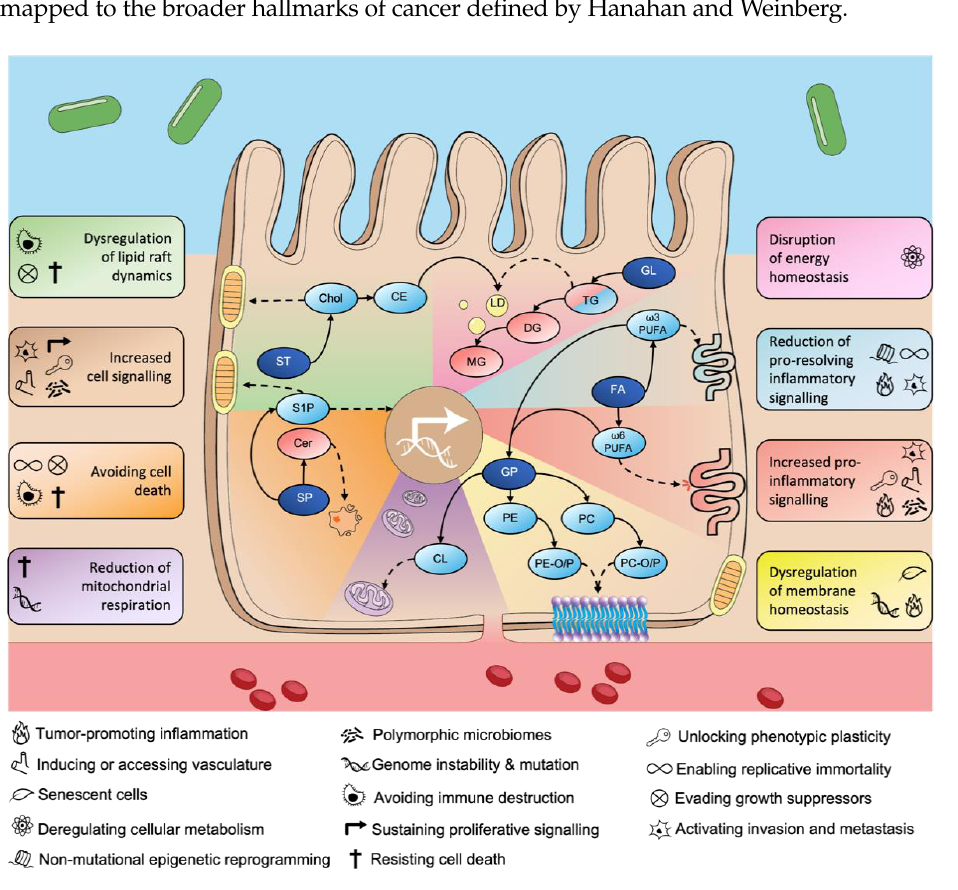
Figure 2. Reprogrammed lipid metabolism and the lipid-associated hallmarks of CRC. Repro- proposed here as the lipid-associated hallmarks of CRC (coloured boxes), each of which may be linked to one or more of the established cancer hallmarks (black icons) described by Hanahan and Weinberg [10–12]. Lipid categories are annotated as dark-blue ellipses, upregulated lipid classes are annotated in light-blue ellipses, downregulated lipid classes are annotated in red ellipses, solid black lines represent directly related lipid(s), and dotted black lines represent lipids involved with the lipid-associated hallmarks of CRC (icons). FA, fatty acid; GL, glycerolipid; GP, glycerophos- pholipid; ST, sterol; SP, sphingolipid; Chol, cholesterol; CE, cholesteryl-ester; Cer, ceramide; S1P, sphingosine-1-phosphate; PC, phosphatidylcholine; PC-O/P, ether-containing PC lipids; PE, phos- phatidylethanolamine; PE-O/P, ether-containing PE lipids; CL, cardiolipin; TG, triacylglyceride; DG, diacylglyceride; MG, monoacylglyceride; LD, lipid droplet; PUFA, poly-unsaturated fatty